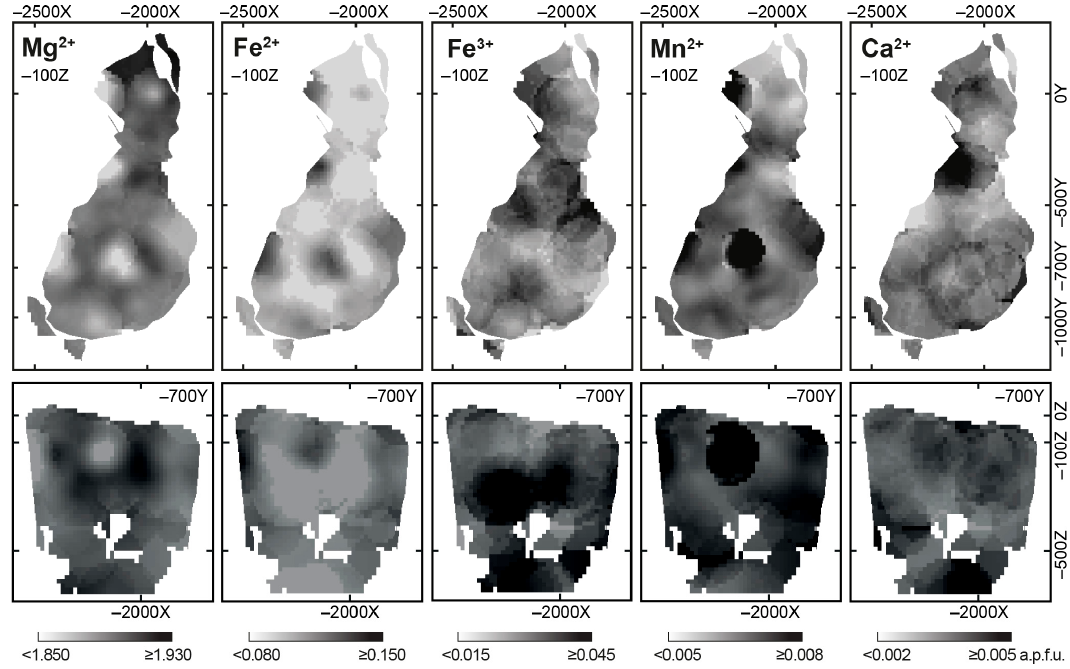
Figure 8. Variations in forsterite composition ( apfu ) within the Kovdor baddeleyite-apatite-magnetite